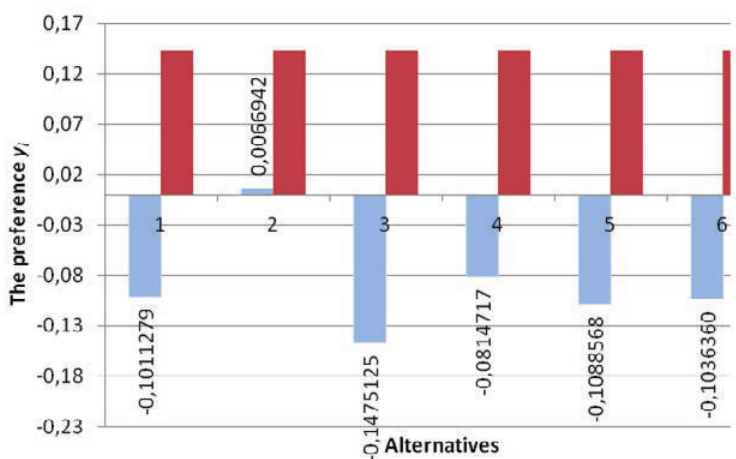
of the 6 apartments in naujoji Vilnia, Vilnius, lithuania Figure 2. the comparison of the preferences y i (dark columns) with the ideal indoor environment (light